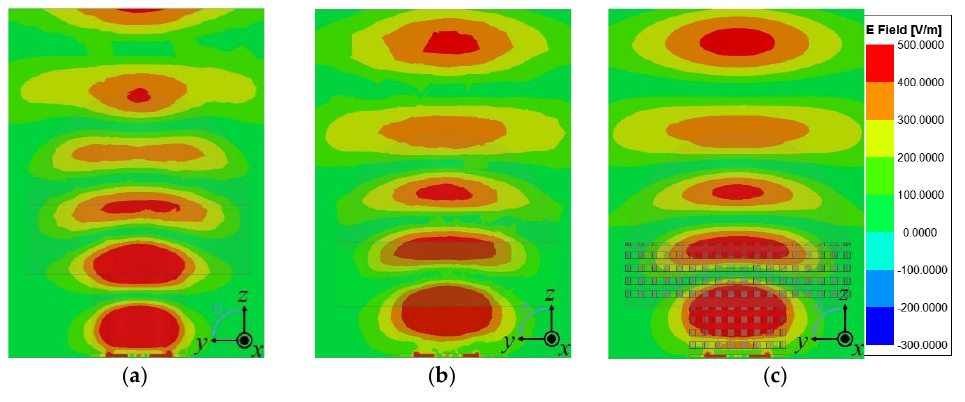
Figure 6. Proposed design (model 3). ( a ) Simulation model. ( b ) Perspective view of the proposed design. ( c ) Reflection coefficient. ( d ) 𝜃 -sweep radiation pattern ( 𝜙 = 0° ).